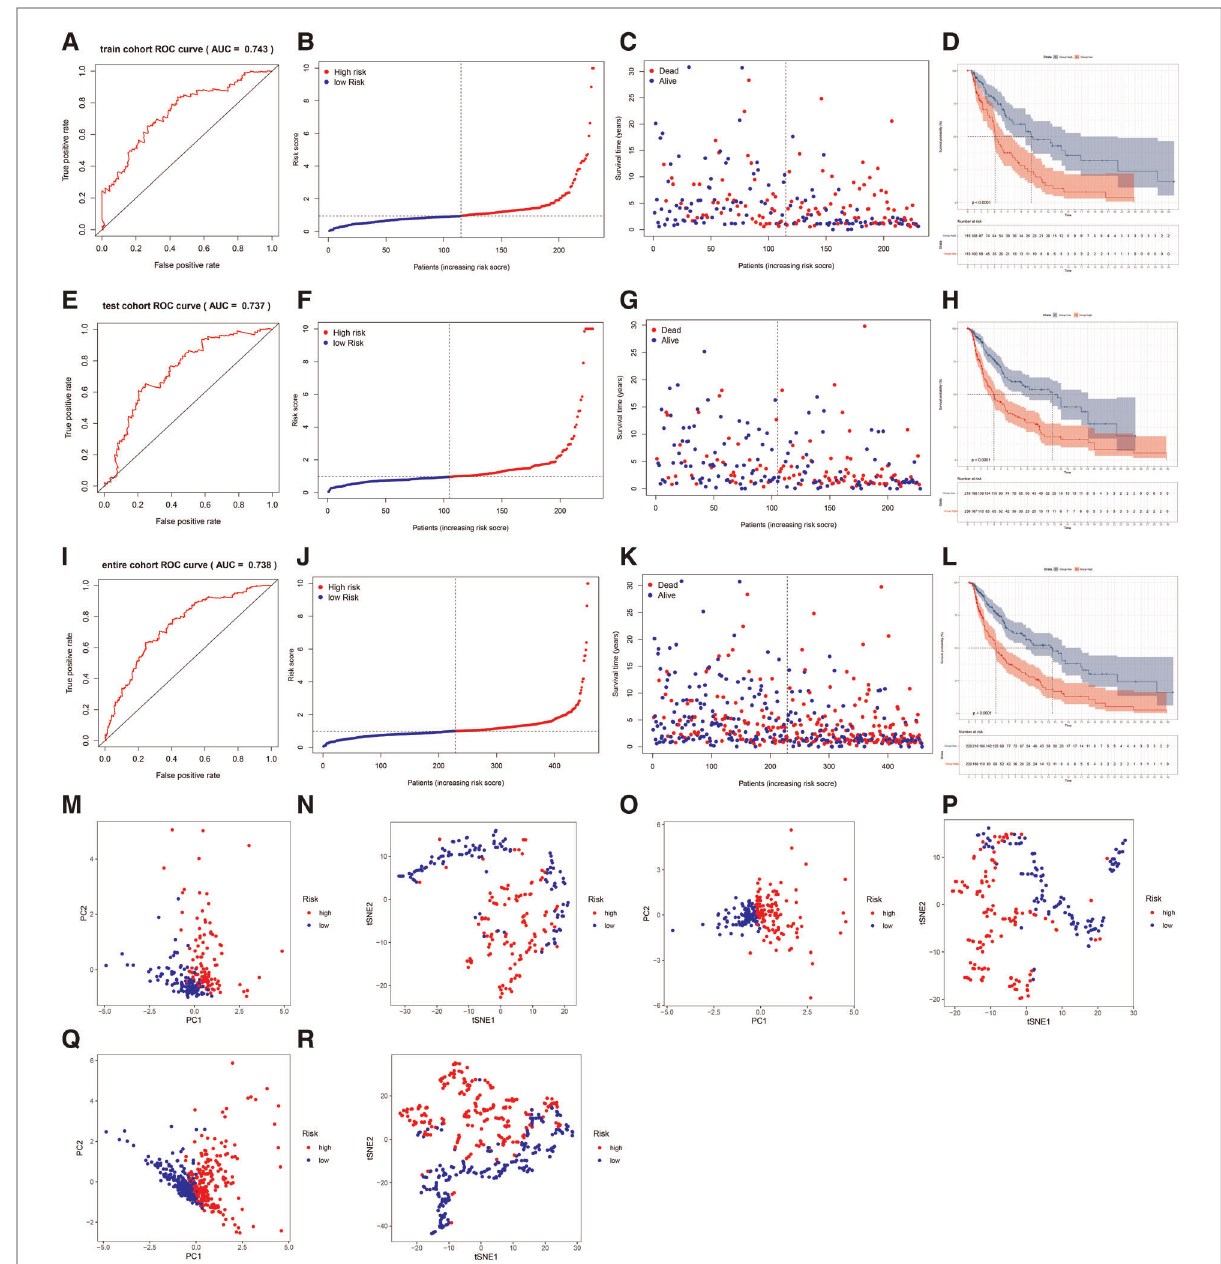
FIGURE 3 Evaluation and validation of the lncRNA signature in the training, testing, and entire cohorts. ( A ) AUC of the lncRNA signature for predicting 5-year survival in the training cohort. ( B ) The rank of the calculated risk score in the training cohort. ( C ) The survival status and survival time in the training cohort. ( D ) Kaplan-Meier survival curves of the high-risk patients and low-risk patients in the training cohort. ( E – H ) The lncRNA signature was validated in the testing cohort. ( I – L ) The lncRNA signature was validated in the entire cohort. ( M,N ) PCA and t-SNE analysis of the training cohort. ( O,P ) PCA and t-SNE analysis of the test cohort. ( Q,R ) PCA and t-SNE analysis of the entire